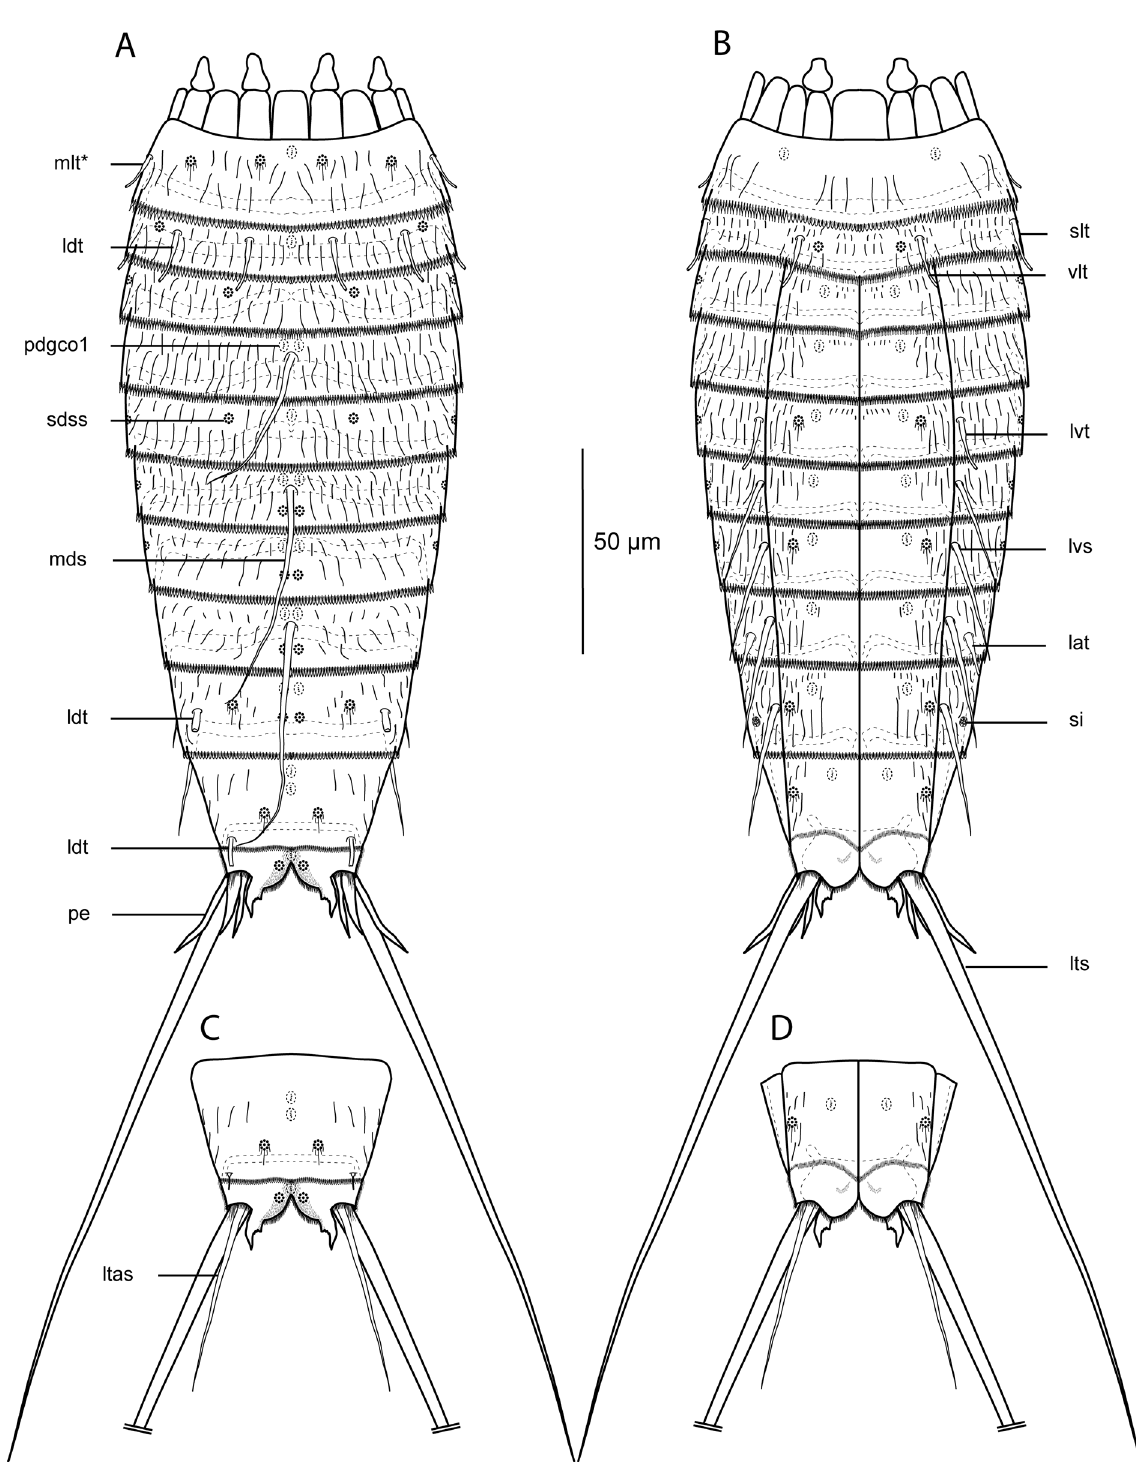
Fig. 17. Line art illustrations of Echinoderes frodoi sp. nov. A . ♂, dorsal view. B . ♂, ventral view. C . ♀, segments 10–11, dorsal view. D . ♀, segments 10–11, ventral view. Abbreviations: see Material and